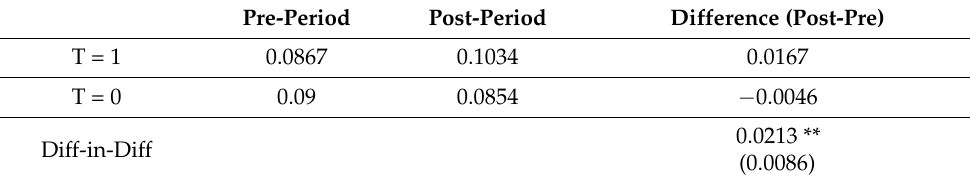
Table 5. Unconditional DiD Estimates for Propensity to Purchase Major Appliances.